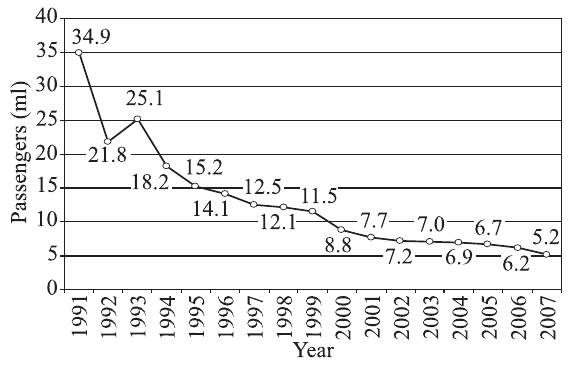
Fig. 1. Dynamics of passenger fl ows, 1991–2007